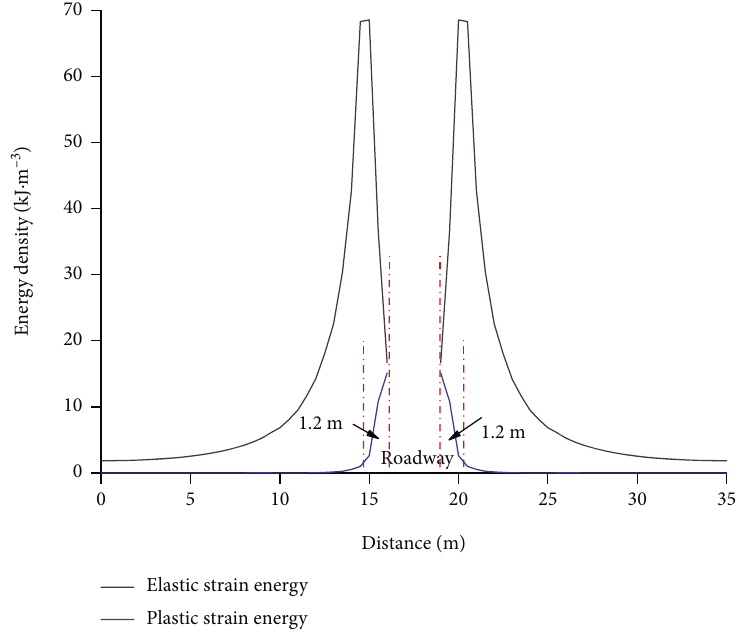
Figure 11: Energy change curve of ribs of